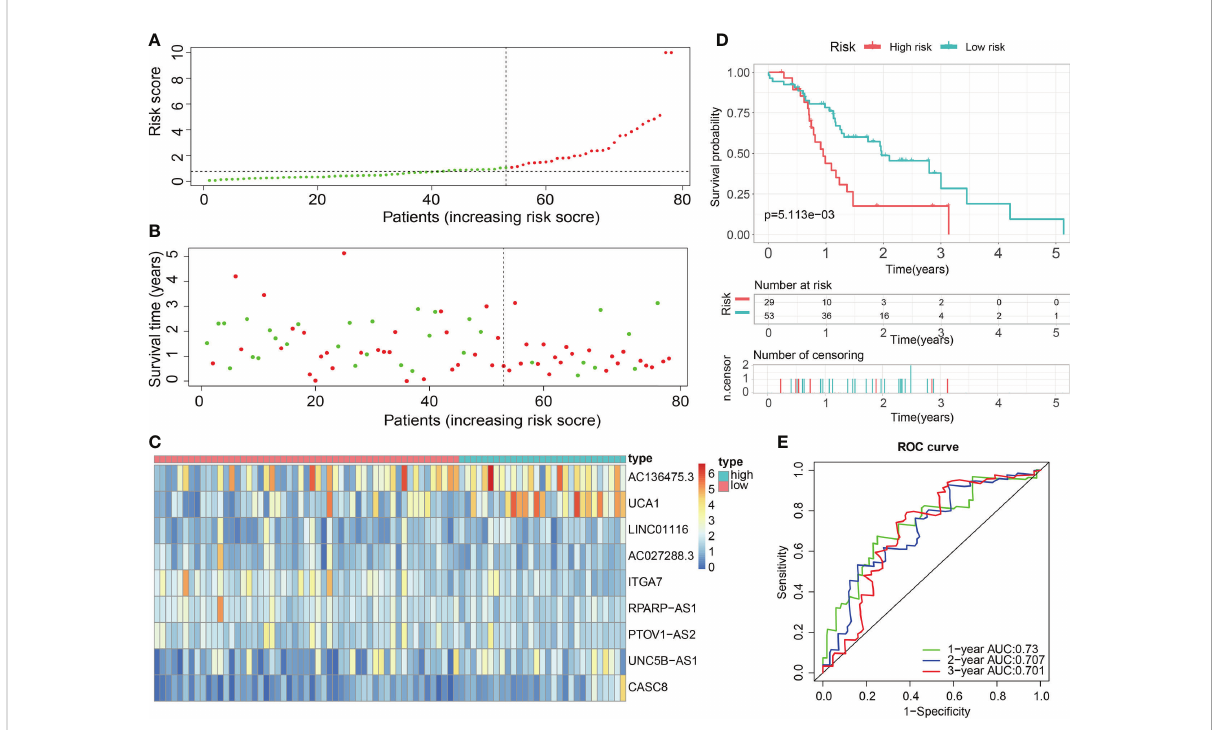
FIGURE 11 External validation of the robust ECM-APP in the test3 cohort. (A) Sectionalization premised on the median risk score. (B) Survival status and risk score distributions. (C) Heatmap demonstrated the expression pro fi les of 9 genes integrated into the prognostic signature. (D) Survival curve of OS time in low-risk and high-risk subgroups. (E) ROC curve of 1-, 2-, and 3-years of in test3 cohort; areas under the curve (AUC) of the curve are 0.73, 0.707, and 0.701,